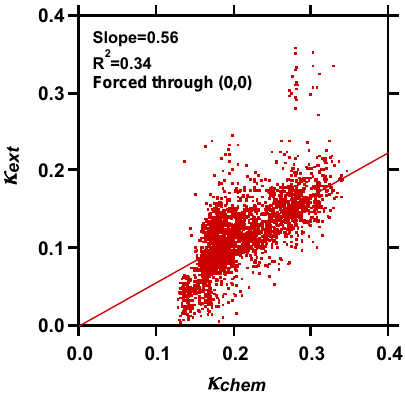
Figure A3. Values of κ ext determined from fitting Eq. (6) to the f (RH) data plotted as a function of κ chem calculated from aerosol composition measurements using κ -Köhler theory (Eq. 3).